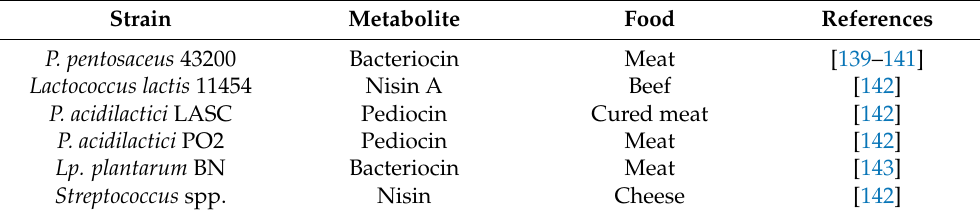
Table 3. LAB against C. botulinum growth and toxin production in foods. Strain Metabolite